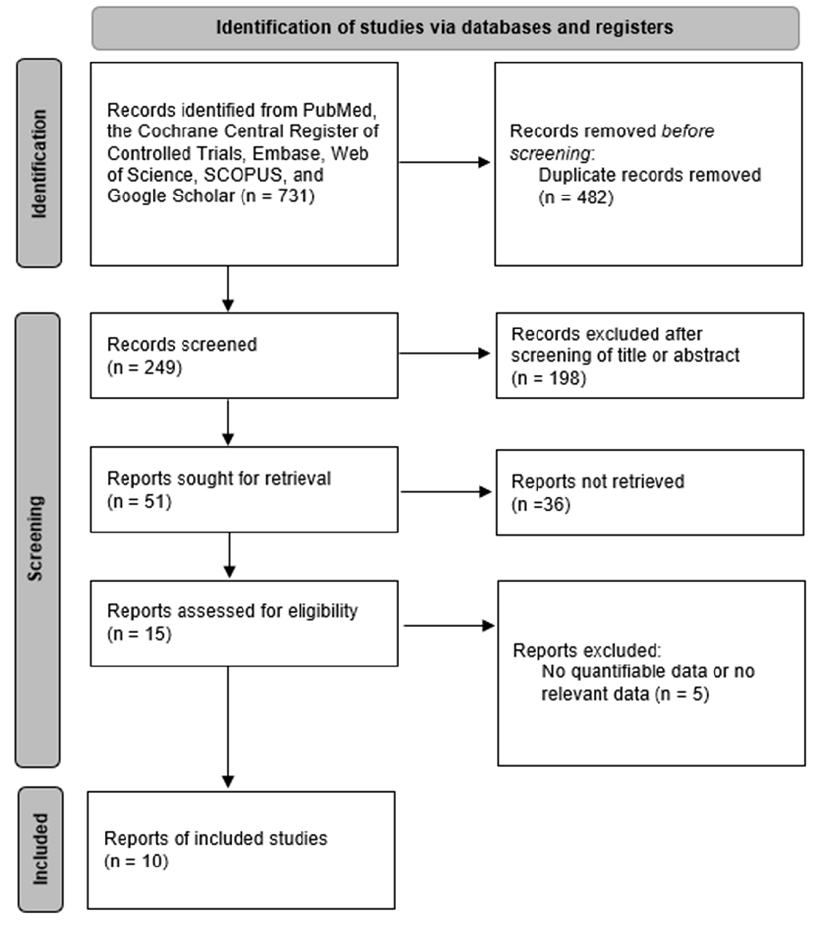
Figure 1. Diagram of selection of studies.